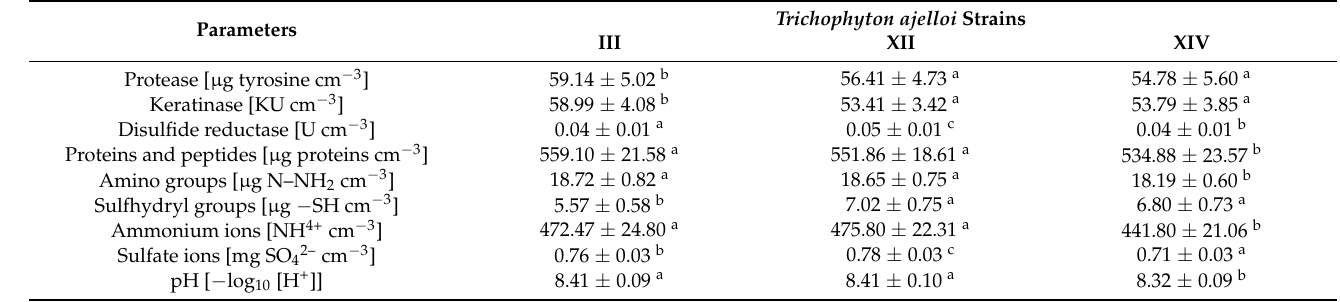
Table 6. Differences in the ability of Trichophyton ajelloi strains to biodegrade chicken feather